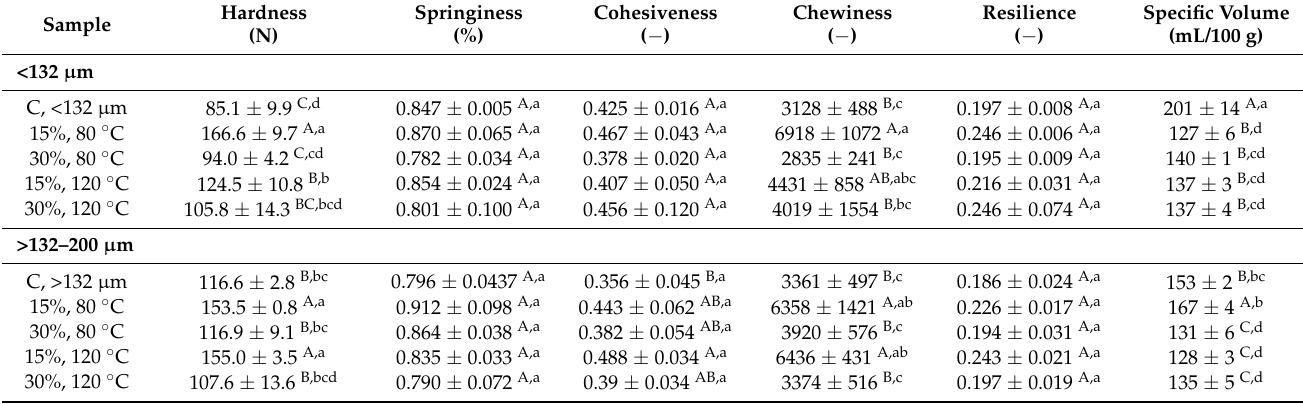
Table 6. Texture parameters and specific volumes of breads